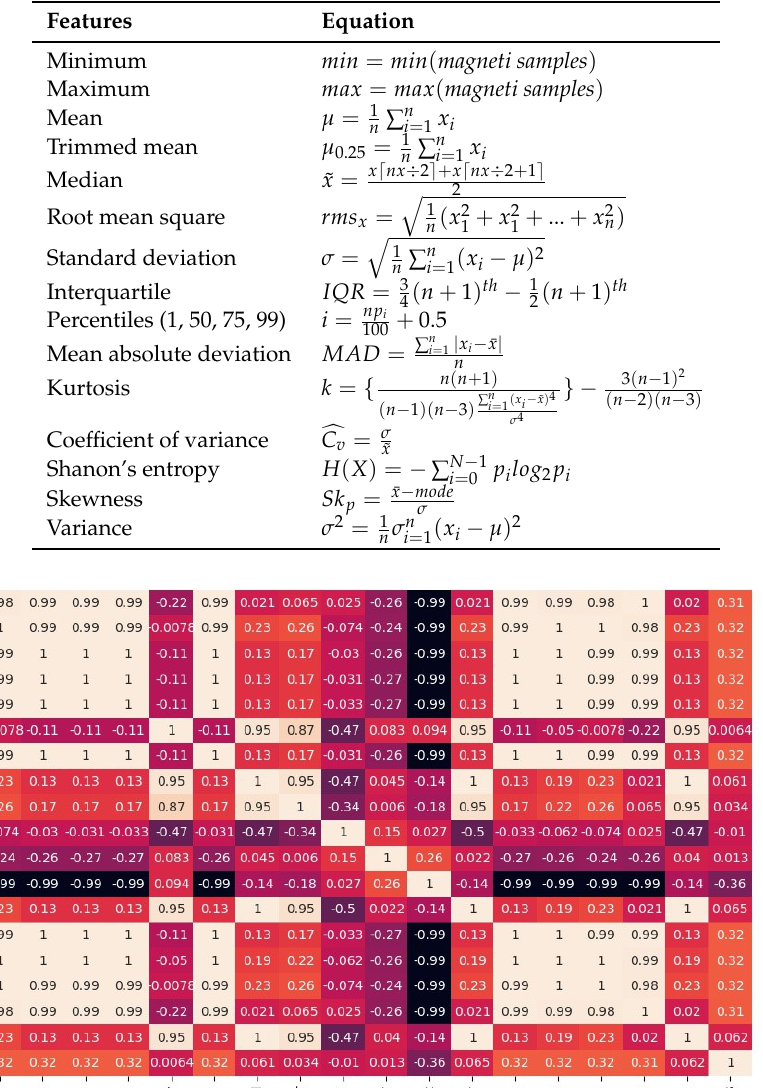
Table 1. Features extracted from magnetic data.